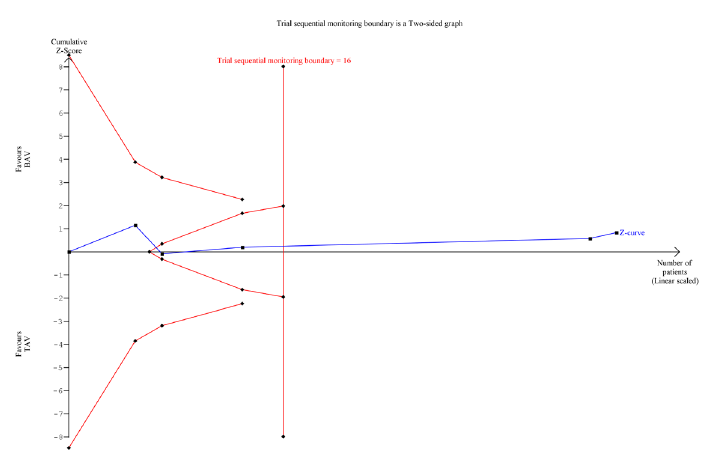
Fig. 7 - Trial sequential analysis diagram for 30-day mortality. BAV=bicuspid aortic valve; TAV=tricuspid aortic